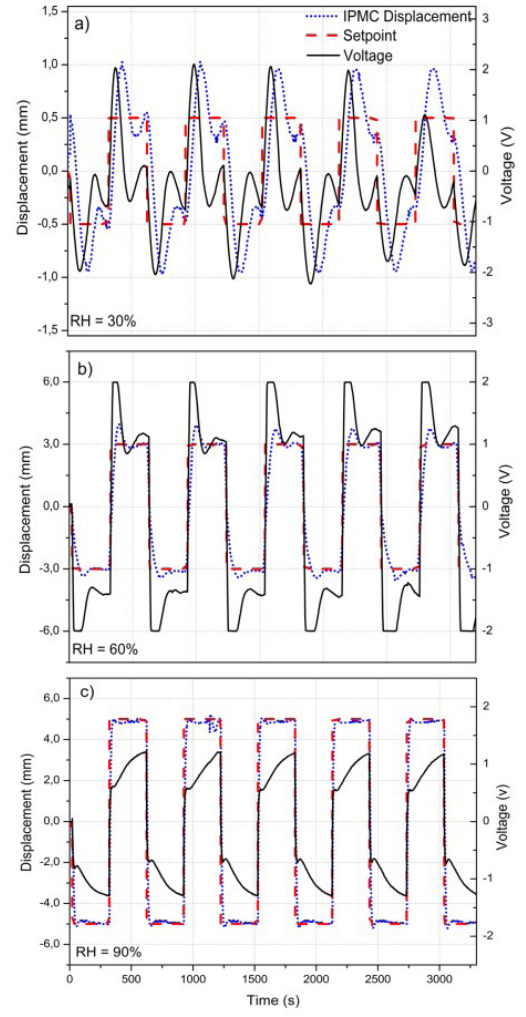
Figure 9. IPMC Displacement and voltage response as a function of time. a) RH = 30%, b) RH = 60%, and c) RH =